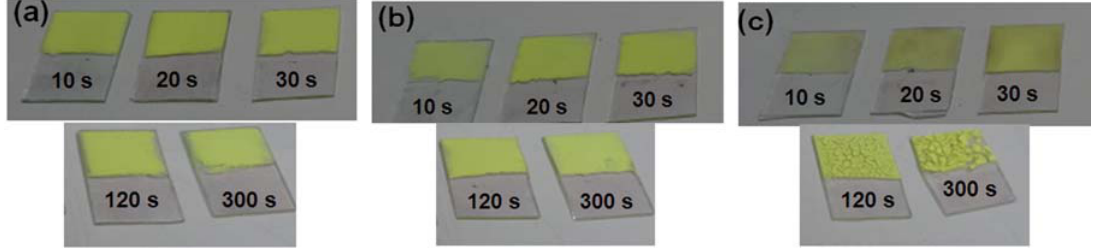
Figure 3. Photographs of the β -sialon:Eu 2+ deposits, mixed with various amounts (0.05–1 g) of the SnO , prepared by the EPD process at 10–300 s depositing time: ( a ) 0.05 g; ( b ) 0.1 g; 2 and ( c ) 1